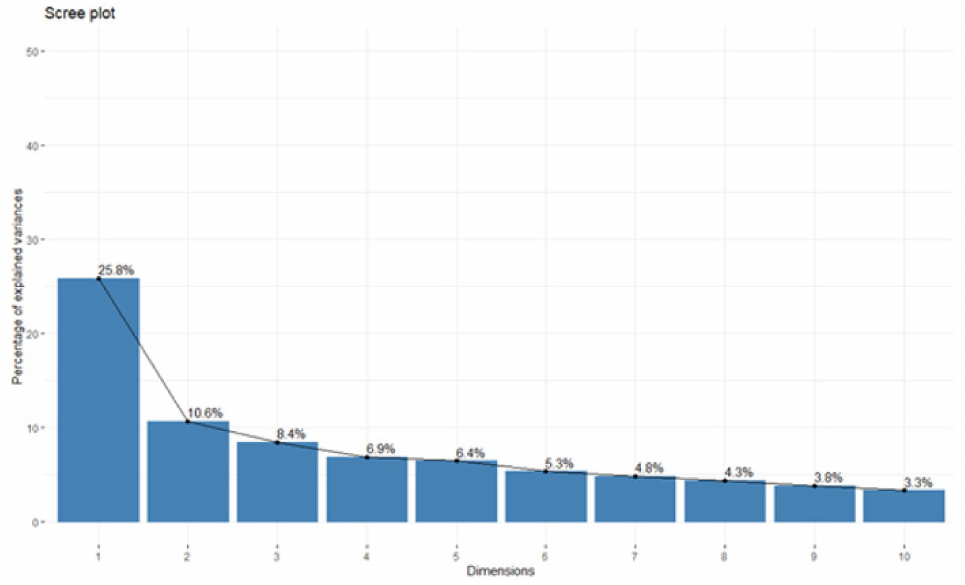
Figure 2. SCOOHP (23 items) eigenvalues graph. The first axis of the principal component analysis (PCA) concentrates 25.8% of the in- formation. The second, third, fourth, fifth, and sixth axes contained 10.60%, 8.4%, 6.9%, 6.4%, and 5.3%, respectively. We use approximately 63.4% of total variance, in the first six axes, retained for the confirmatory factor analysis. In Figure 3, we show the individuals’ factor maps for the SCOOHP scale with 23